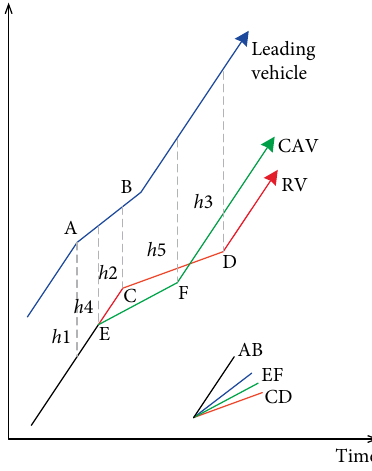
Figure 5: Illustration of the idea of “slow-in” and